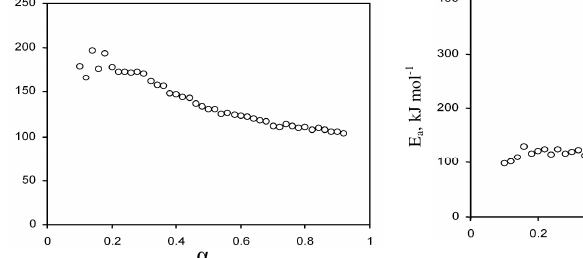
Figure 3. Variation of E with α for a second stage decomposition of HBAPPA by FWO